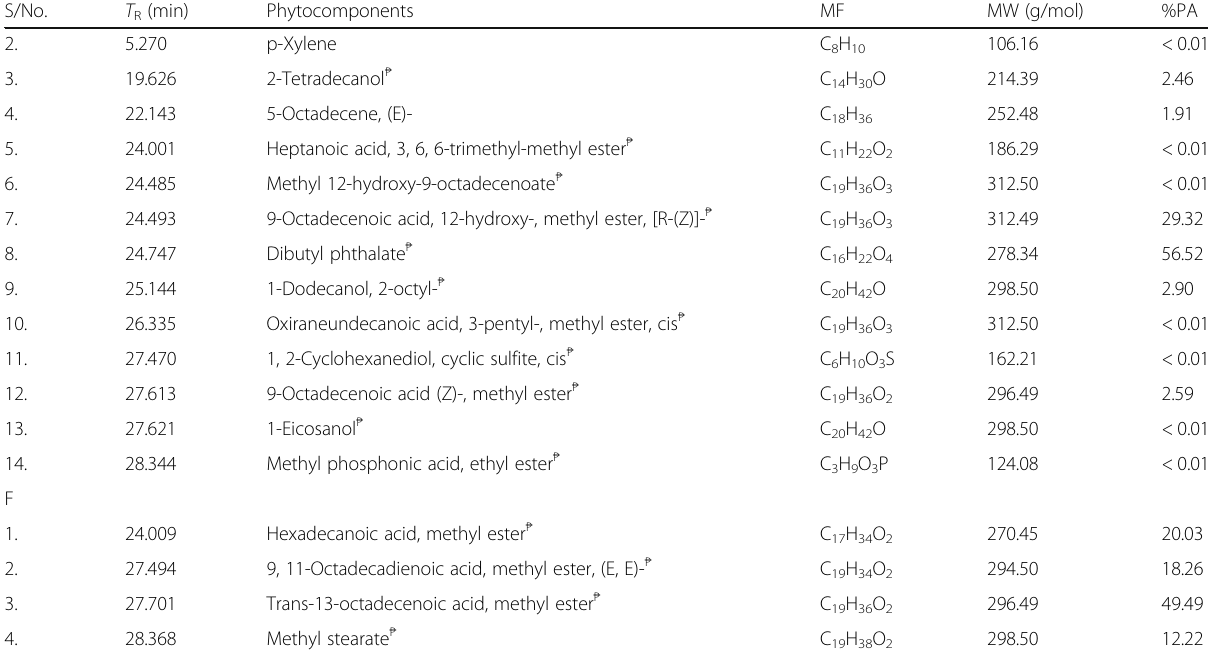
Table 4 Phytocomponents of (A) petroleum ether extract of A . occidentale , (B) ethylacetate extract of A . occidentale , (C) n -hexane extract of P . guajava , (D) chloroform extract of P . guajava , (E) ethylacetate extract of P . guajava , and (F) ethylacetate extract of T . catappa (Continued)